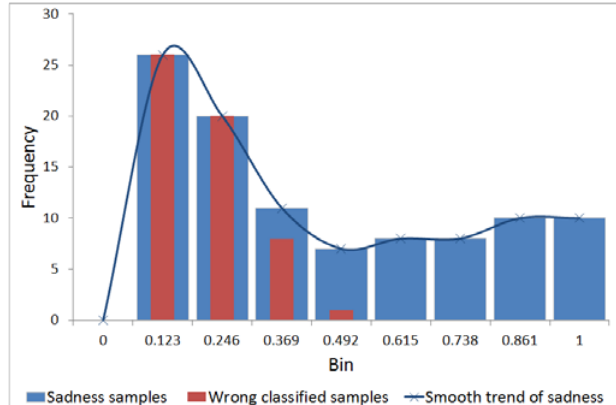
Figure 5. Histogram of sadness samples.